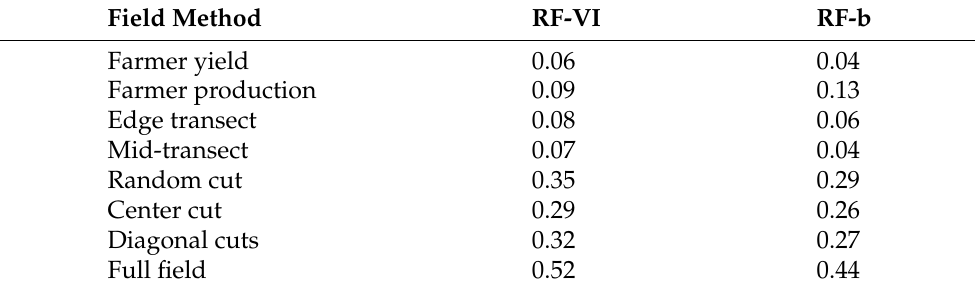
Table A2. Proportion of variation explained ( R 2 ) for yield prediction models. The highest score for any of the 45 single-variable linear regression models (LR-1) or for the 990 two-variable linear regression models (LR-2) and for Random Forest (RF) models.